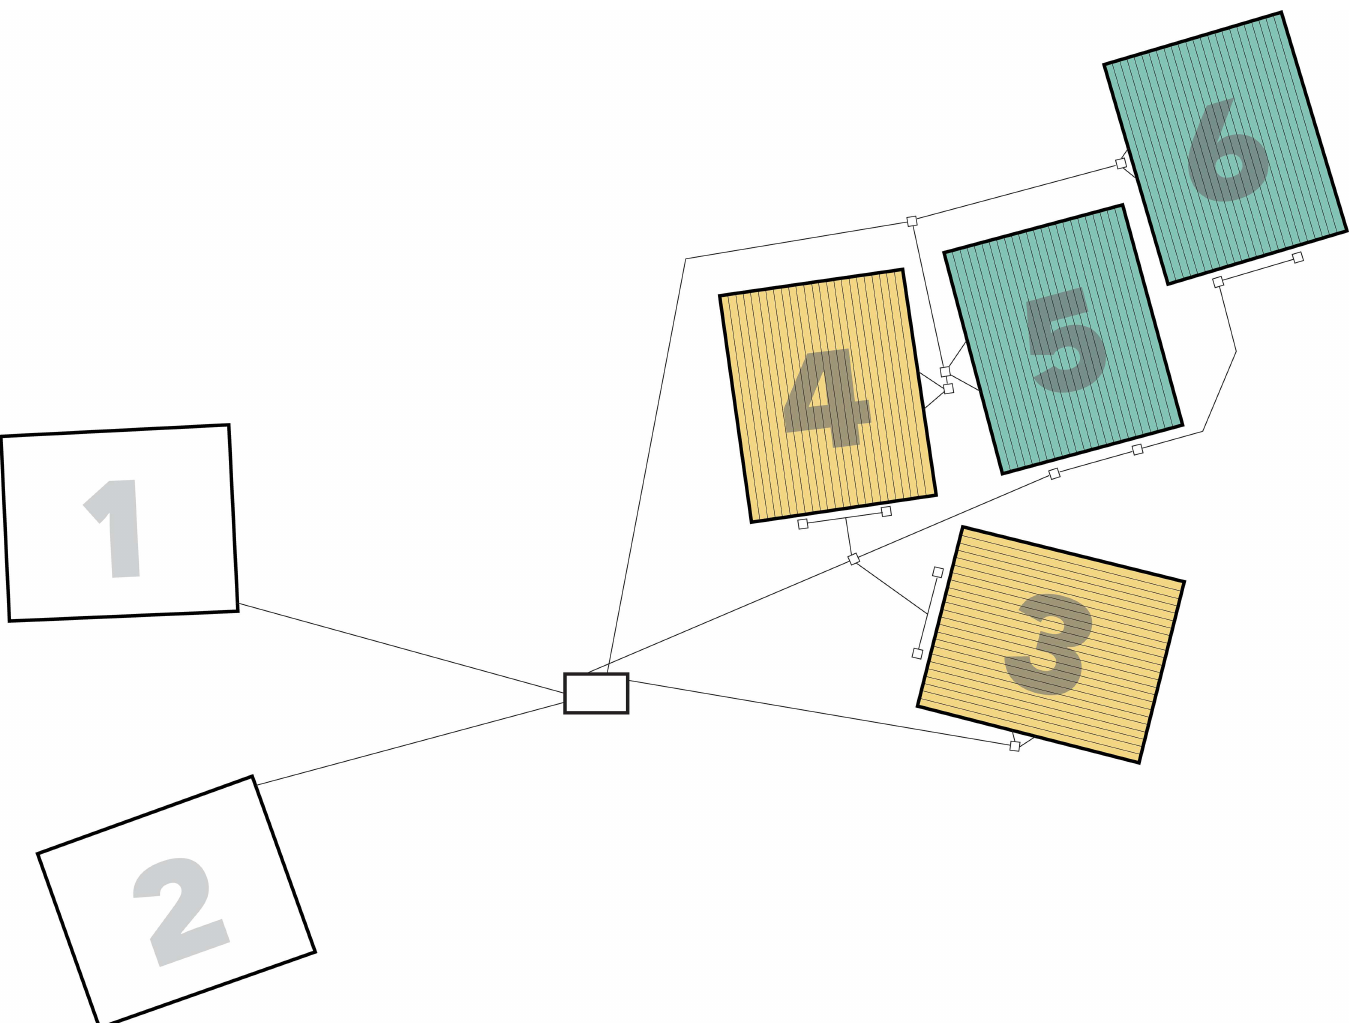
Fig 1. Diagram of referenceand heated plots, including wiring and conduit systems. Each plot is 11 X 13.5 m 2 . Plots 1 and 2 are reference , 3 and 4 are warmed , and 5 and 6 are warmed +FTC . EPDM synthetic rubber roofing membranematerialwas installedto 30 cm depth betweenthe two types of warmed plots (i.e., betweenplots 3–4 and 5–6) to inhibit roots from growinginto different treatments. The parallelgray lines insideplots represent heatingcable and the black lines outsideplots represent heatingcable conduit. The junctionboxes, located alongthe conduit, are represented by white boxes. The equipment shed (center box) houses the control equipment for the